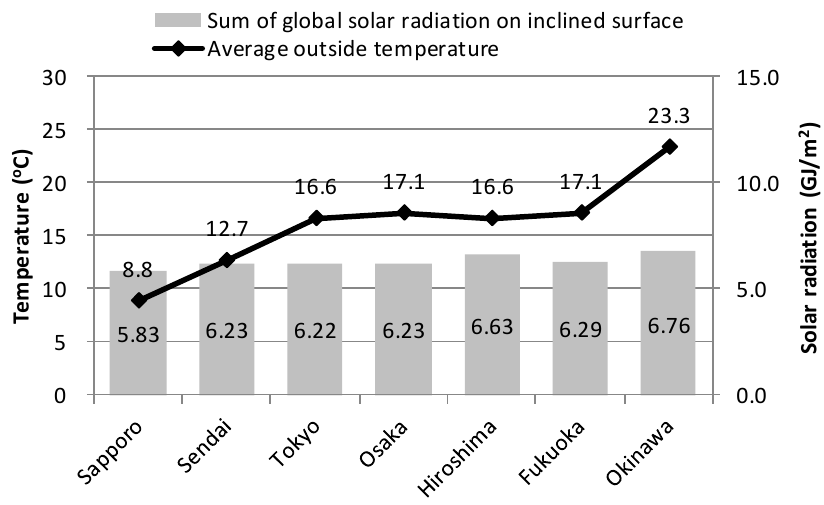
Figure 7. Outside temperature and global solar radiation on inclined surface of each city.